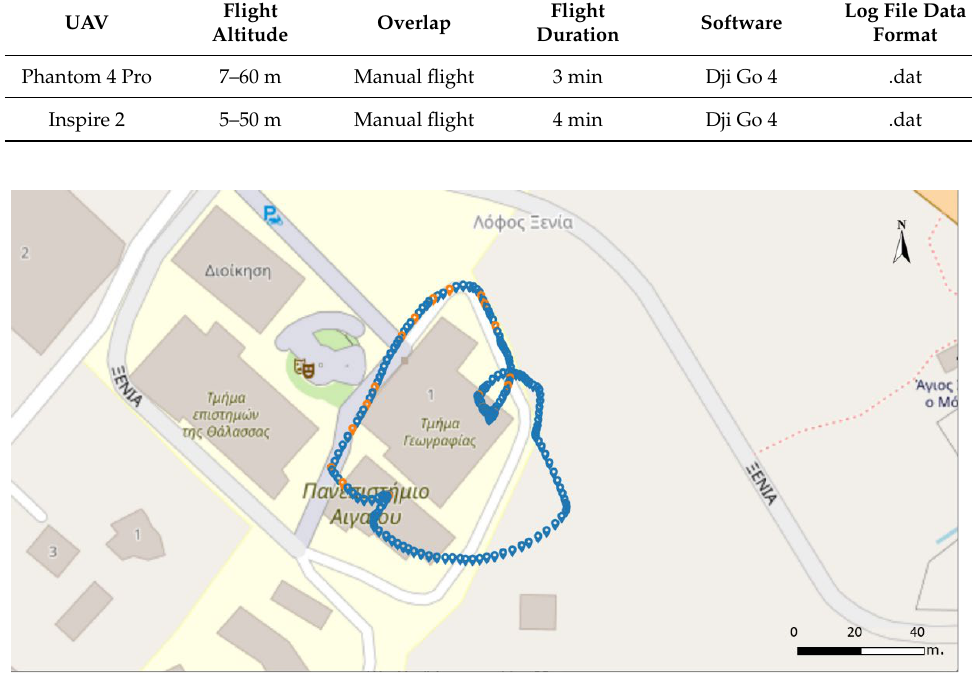
Figure 9. Visualization of trajectory of flight over the University of the Aegean. Blue-colored points